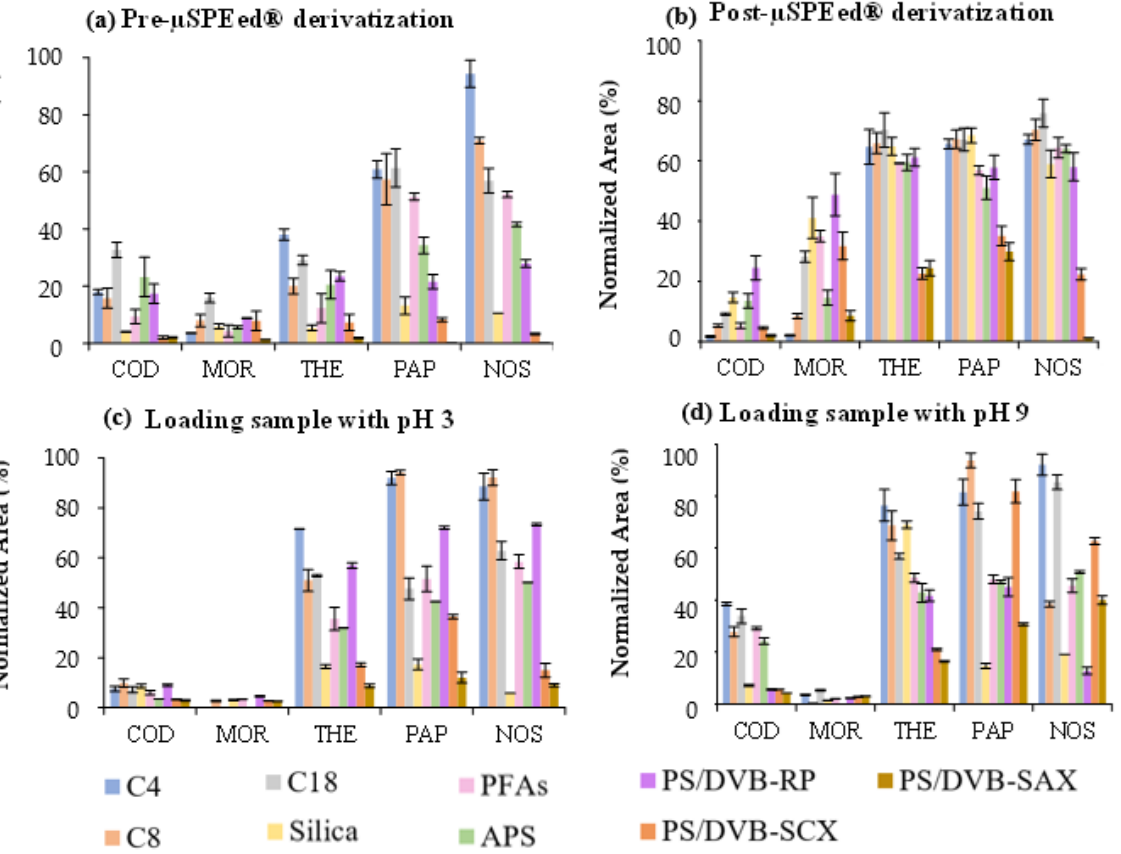
Figure 3. Normalized areas (%) obtained for OAs in the optimization of the µ SPEed ® procedure with nine cartridges: derivatization before ( a ) and after ( b ), acidifying to pH 3 ( c ) or basifying to pH 9 ( d ) in the loading step. All assays were performed with 5 mg/L standard solutions in triplicate; error bars indicate the relative standard deviations (RSDs %).